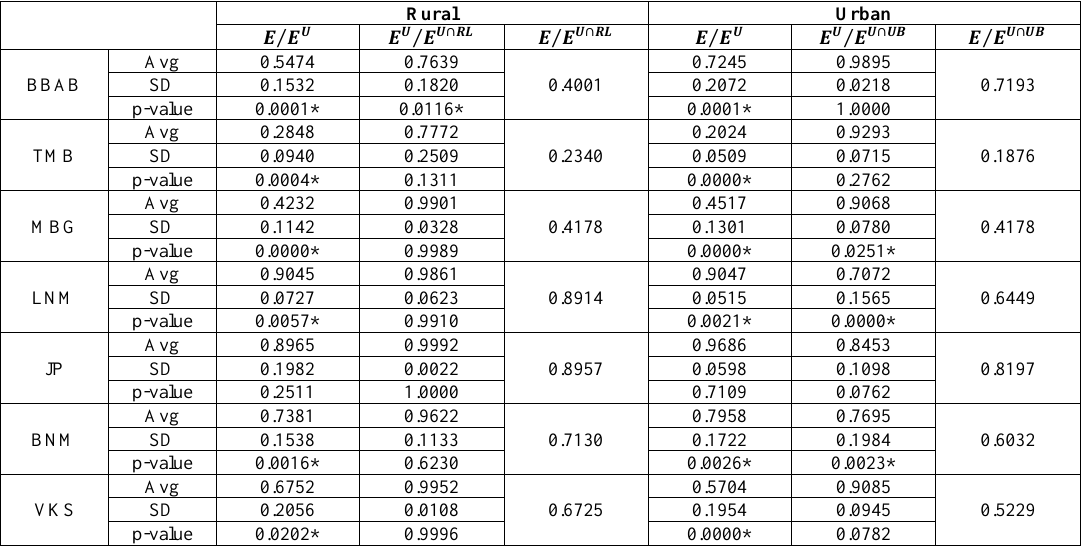
Table 5. The average impact of location factor on 𝐸 𝑈 and its significance.